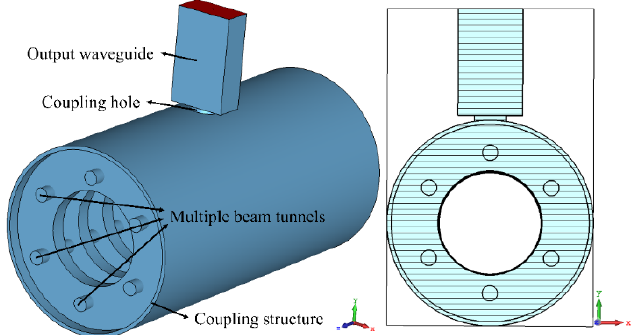
Figure 2. The schematic drawings of the multiple-beam EIO with coaxial structure and its sectional view on the X-Y plane.